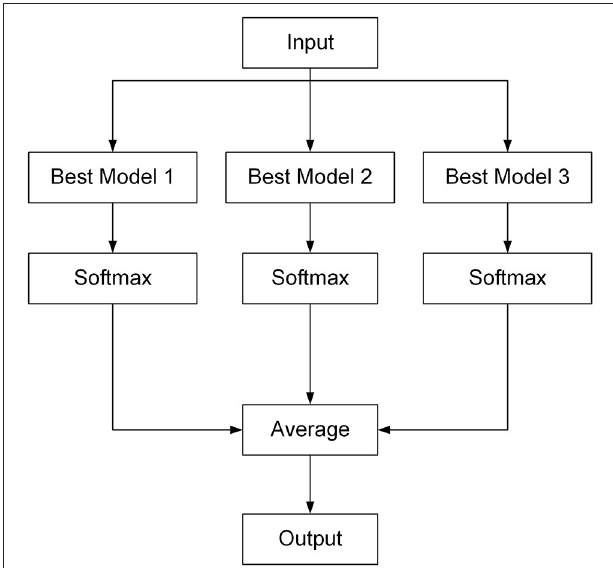
FIGURE 3 | Architecture of the Ensemble Model for rice disease diagnosis.